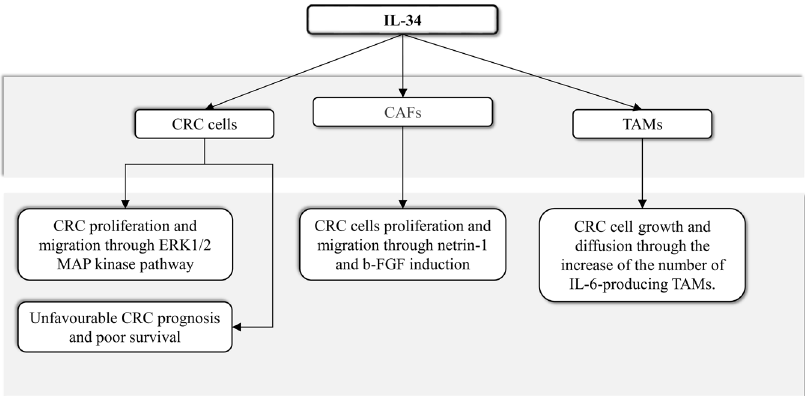
Fig. 3 Schematic view of interleukin-34 effects on speci fi c cell types in CRC microenvironment. CRC colorectal cancer, TAMs tumour- associated macrophages, CAFs cancer-associated fi broblasts, b-FGF basic fi broblast growth